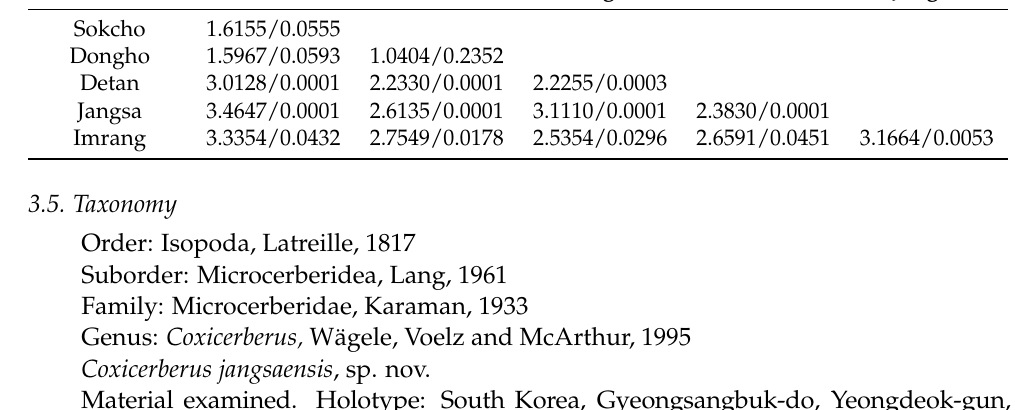
Table 4. Comparison of PE mean shape variation between populations from canonical variate analysis (CVA). Left score: Mahalanobis distance; right score: probability of finding a random value larger than the observed value. Gazin Sokcho Dongho Detan Jangsa Sokcho